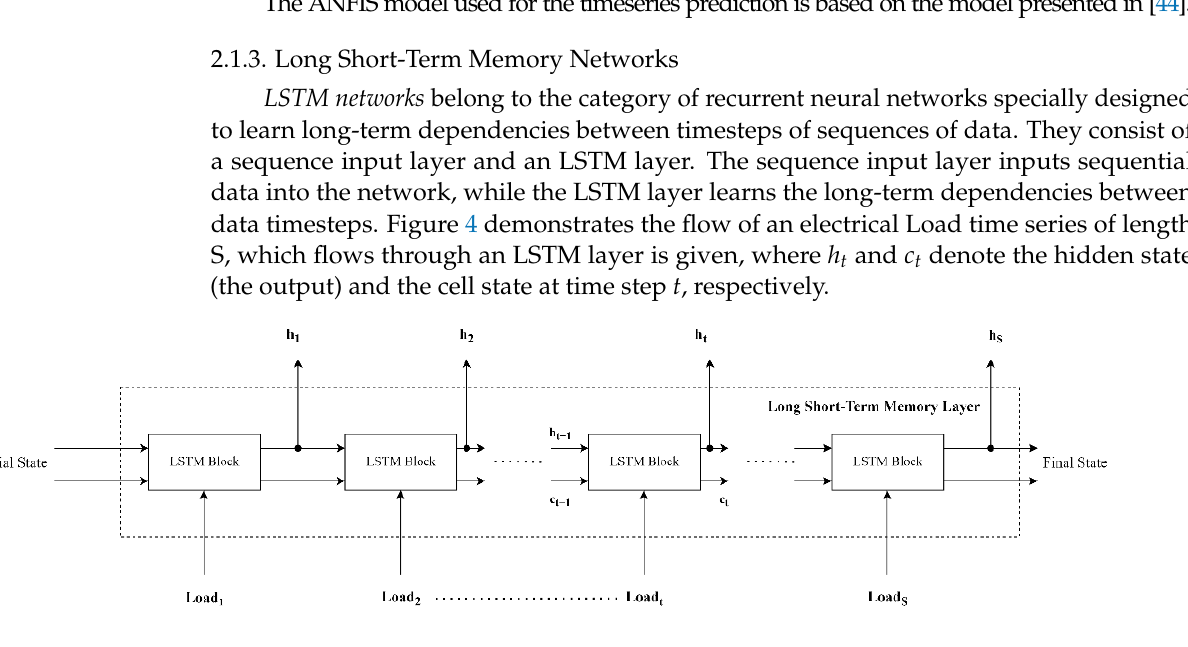
Figure 4. Time series flow through LSTM layer.